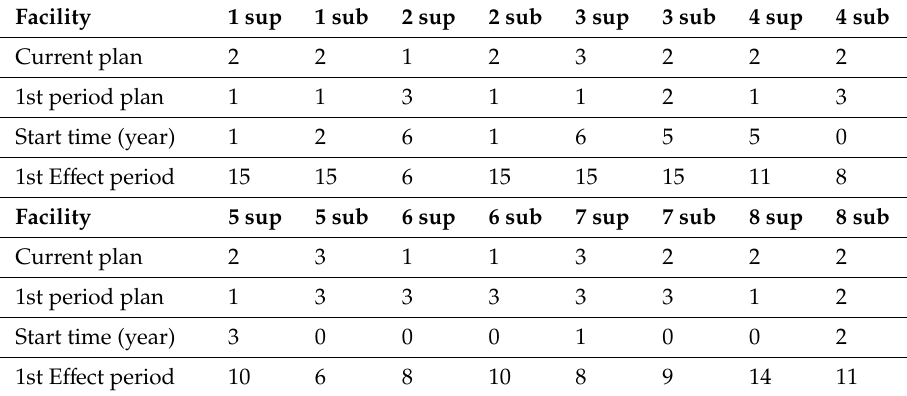
Table 12. Calculation results of